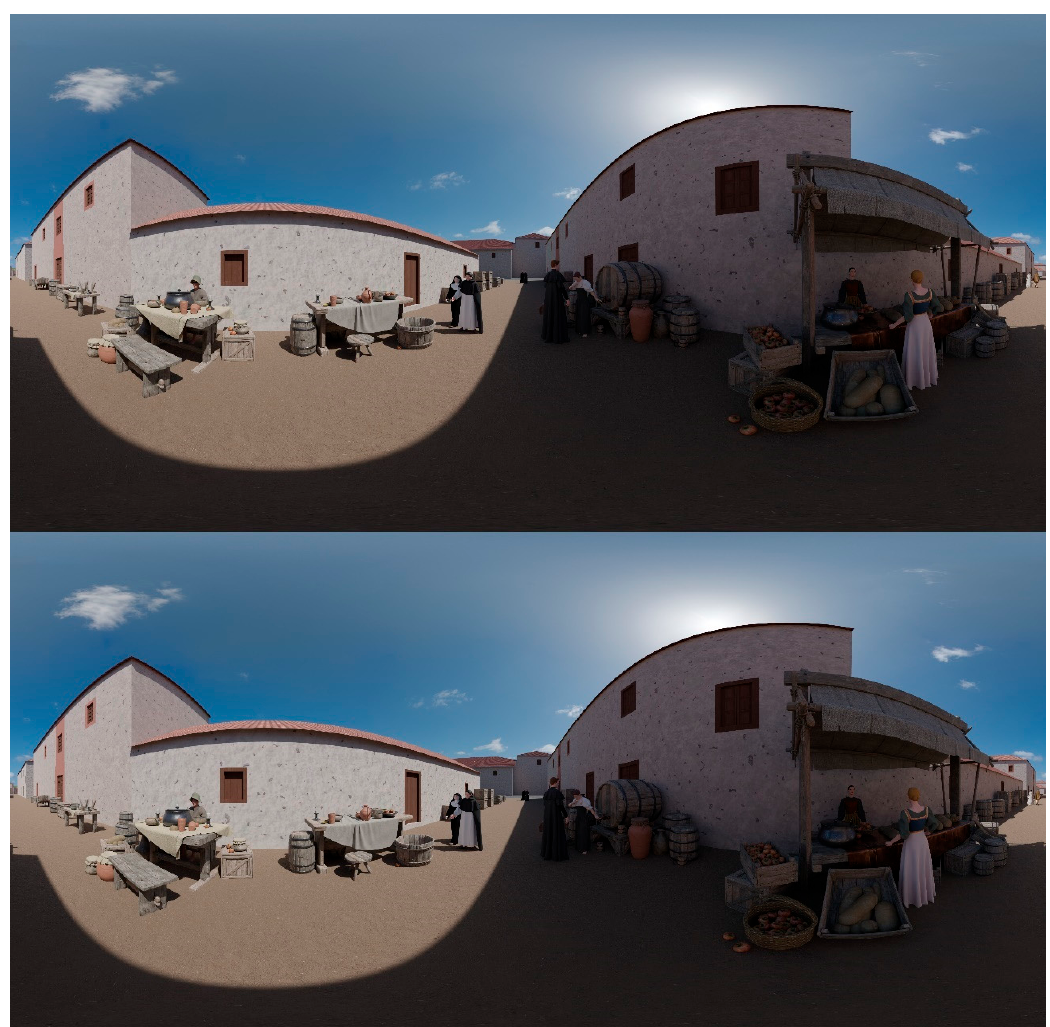
Figure 29. A 360 stereo pair of images to be displayed on a VR headset.